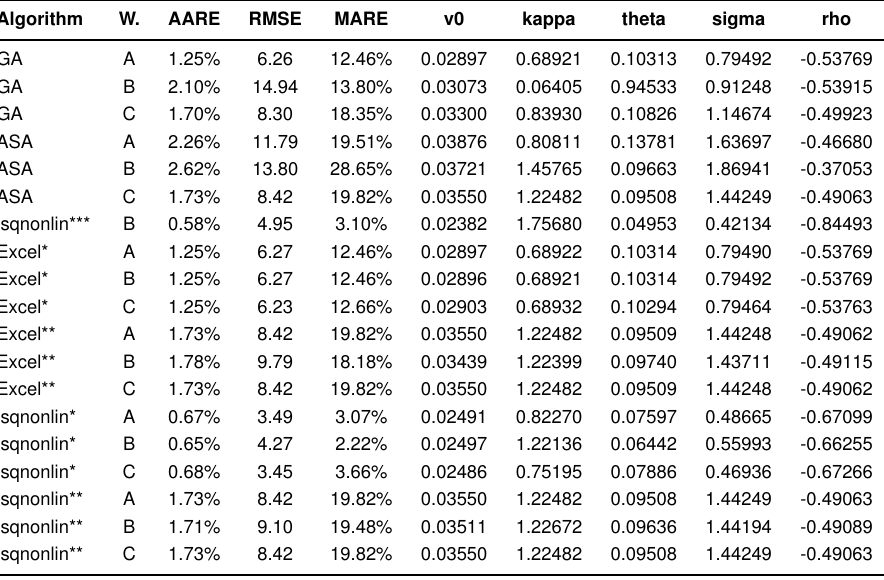
Table 3. Calibration results for March 19, 2013. * denotes initial guess provided by GA. ** indicates initial guess provided using ASA. *** is used for results obtained by deterministic